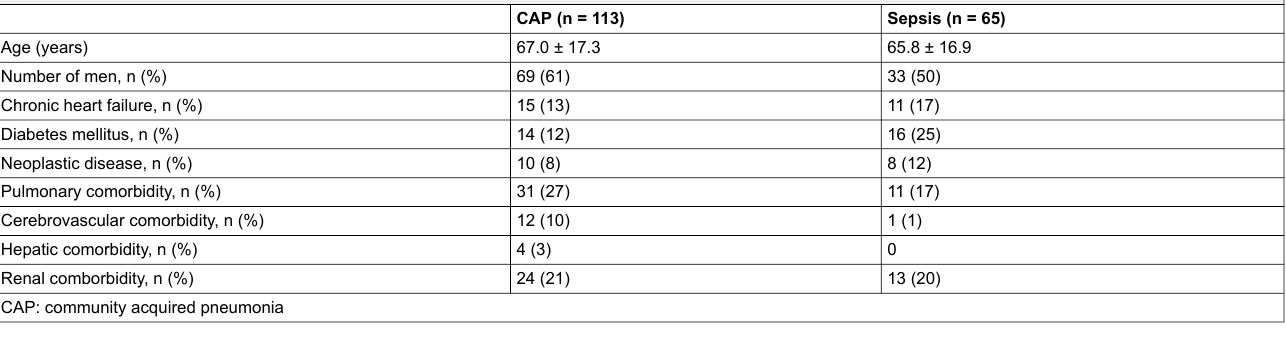
Table 2: CRB-65 score in patients with community acquired pneumonia.